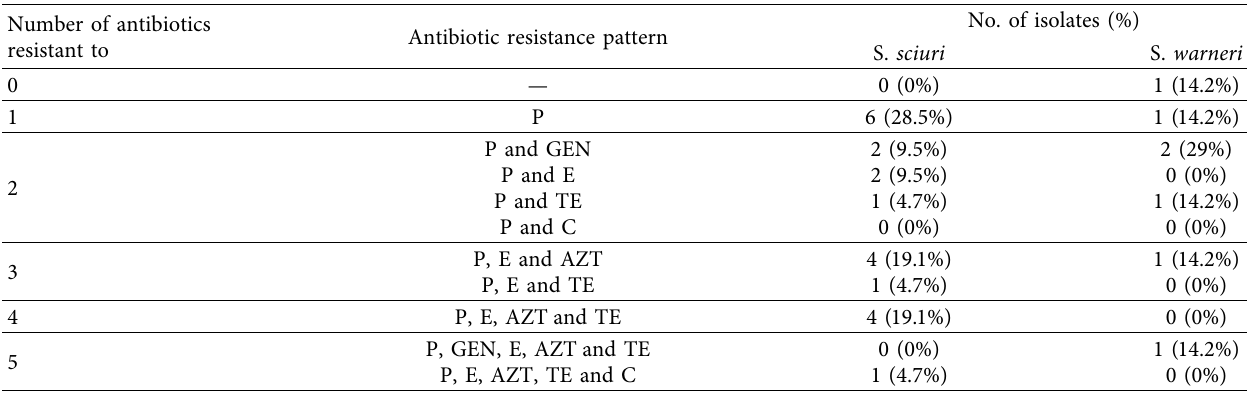
Table 5: Antibiotic resistance pattern showed by Staphylococcus spp. isolated from milk and milk products from various outlets in Juja Sub-County, Kenya.